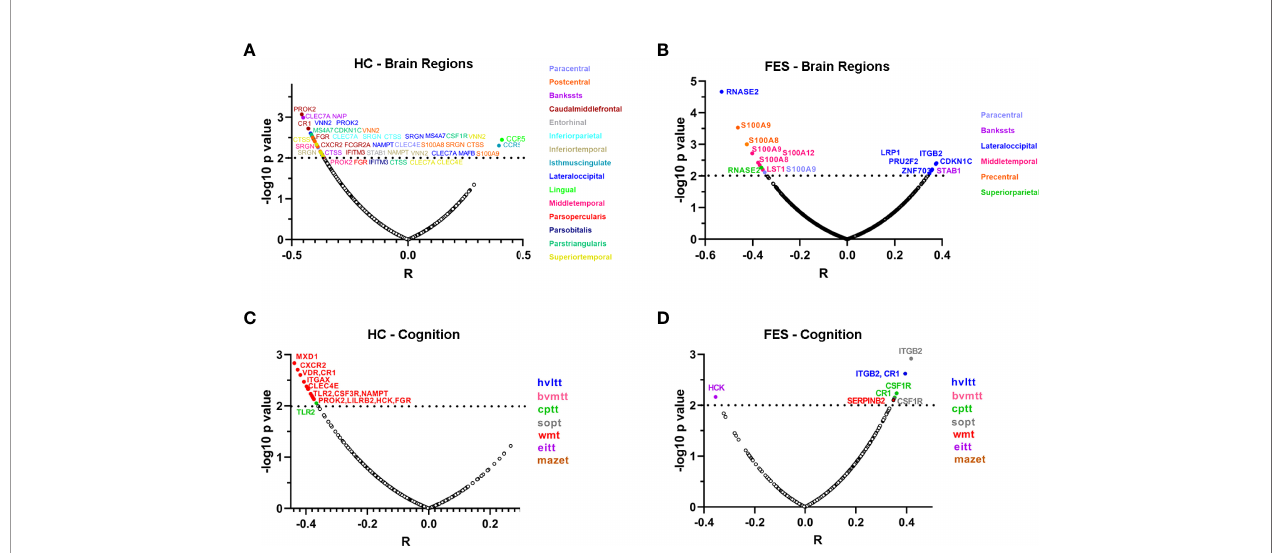
FIGURE 5 | Correlations of individual monocytic DEG mRNAs with cortical thicknesses and MCCB scores highlight more extensive negative features in HCs compared to FES patients. (A-D) Partial correlational analyses of the mRNA levels of 54 monocytic DEGs with the averaged thicknesses of bi-hemispheric 34 cortical regions, after controlling age, sex, and education years, in HC (A) and FES (B) groups, respectively; and with the 7 MCCB subscale scores in HC (C) and FES (D) groups, respectively. The abscissa represents partial correlation coef fi cient. The signi fi cant level was set at p < 0.01. Among all the correlations, only the inverse relationship between the classical monocytic gene RNASE2 and lateral occipital cortical thickness in FES patients passed the FDR (54×34) correction. HVLT, Hopkins verbal learning test; BVMT, brief visual-spatial memory test; CPT, continuous performance test; SOPT, speed of processing test; WMT, working memory test; EIT, emotion intelligence test; MAZET, mazes